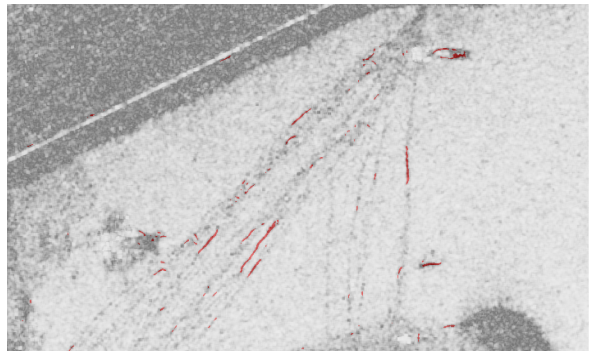
Figure 10. Foot tracks in the POLYGONE data